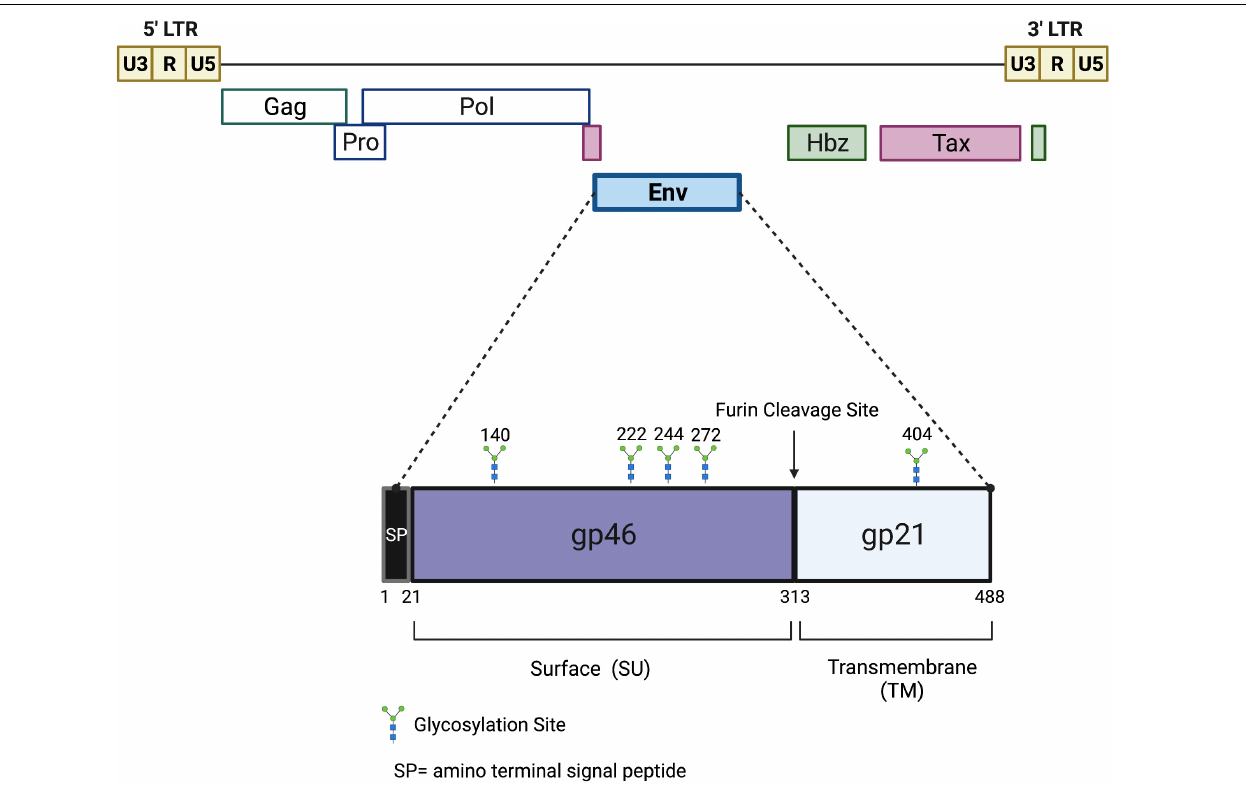
FIGURE 1 | Schematic of the HTLV-1 proviral genome and envelope protein. Viral proteins Hbz, Tax, and Env are potential targets for a protective HTLV-1 vaccine. The viral gag , pro , pol , and env structural and enzymatic genes are flanked by 5 (cid:48) and 3 (cid:48) LTRs. The Hbz and Tax genes are located in the 3 (cid:48) end of the viral genome. Hbz transcription initiates in the 3 (cid:48) LTR. The envelope glycoprotein is comprised of two subunits, gp46 and gp21, which are cleaved at a furin cleavage site. Several potential glycosylation sites are denoted. Drawing is intended to be illustrative and not to exact